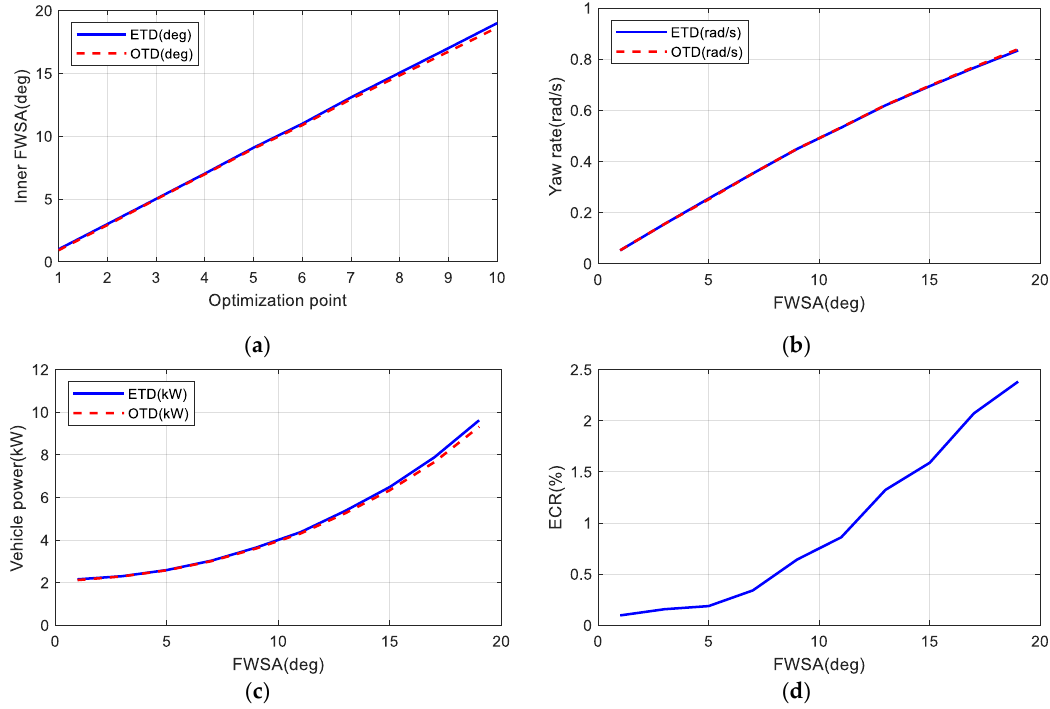
Figure 3. Curves of optimal torque distribution at 30 km/h: ( a ) inner FWSA; ( b ) yaw rate; ( c ) vehicle power; ( d ) energy- efficient ratio.